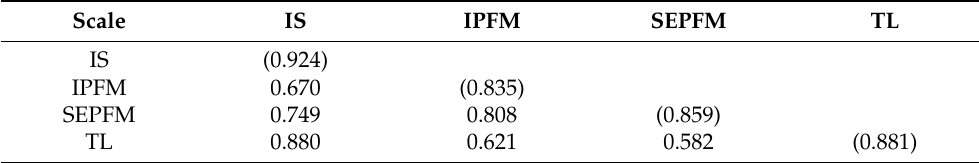
Table 2. Discriminant validity.